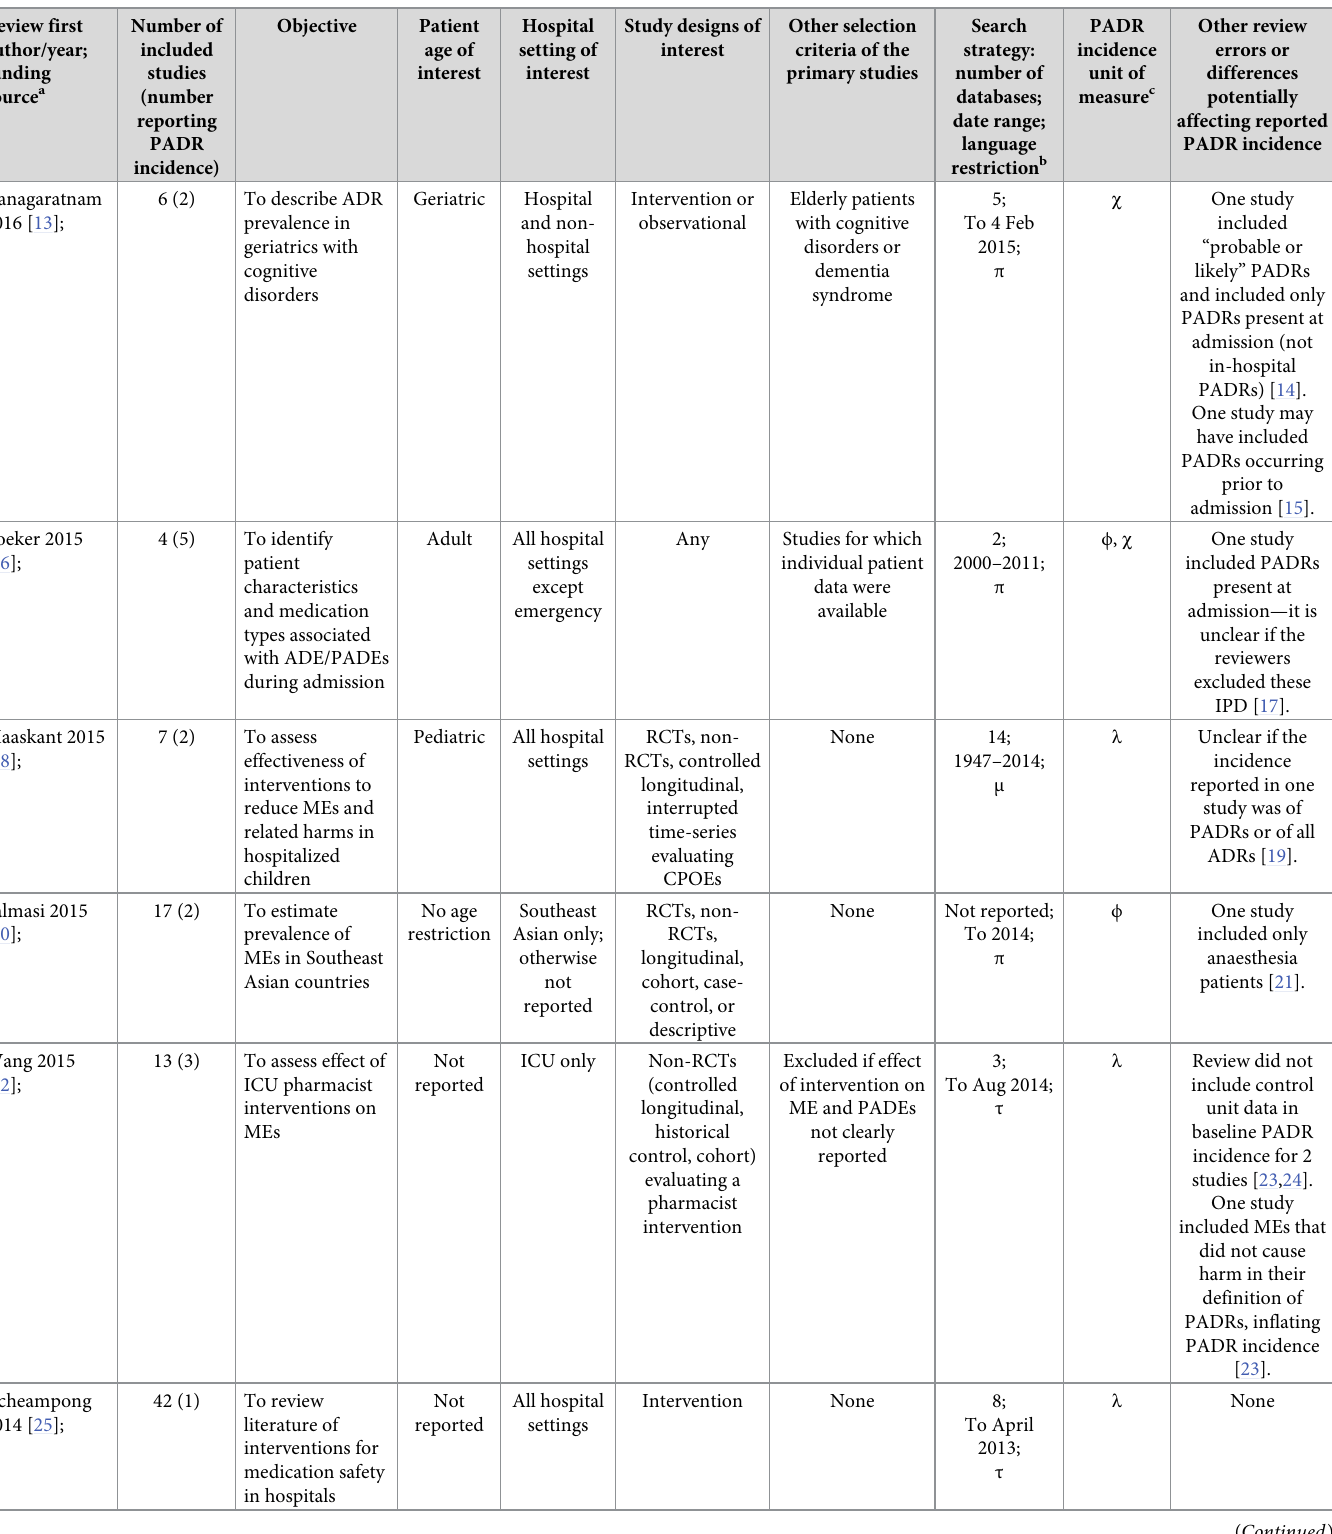
Table 3. Detailed characteristics of the 13 included systematic reviews (focused on elements of the Jadad